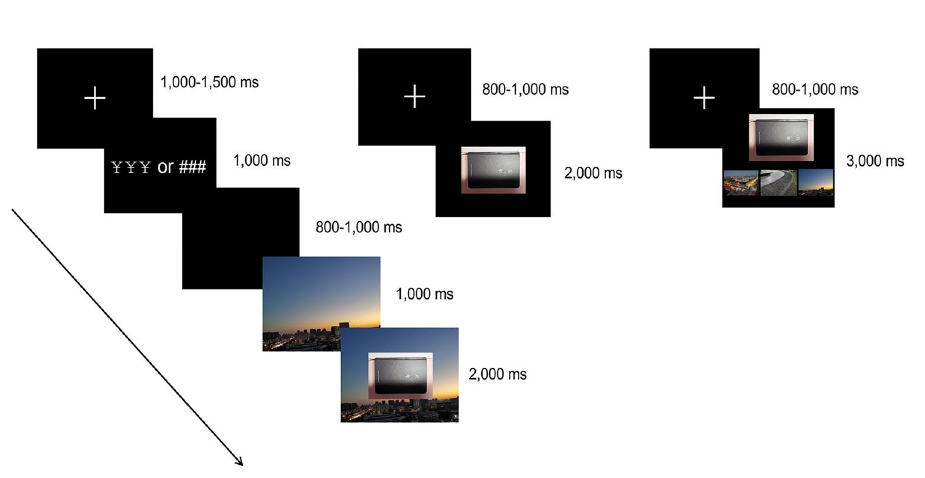
Figure 1. Schematic representations of a trial in the study phase (left), object test phase (middle) and background test phase (right). See text for details. Due to copyright restrictions all original images have been replaced with images taken by the